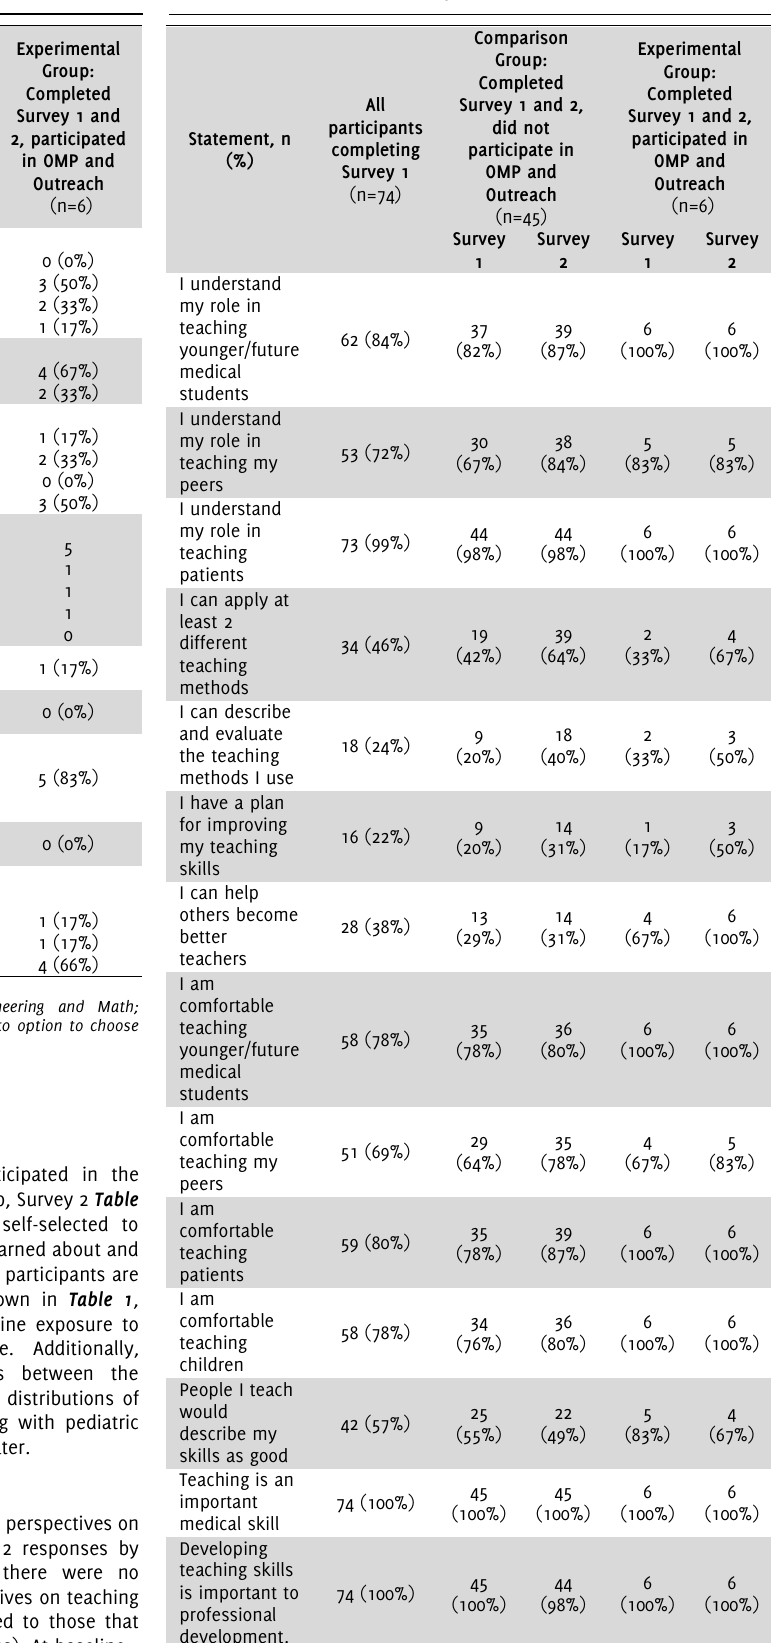
Table 1 . Survey 1 Demographic Data Table 2 . Perspectives on Teaching at Baseline and